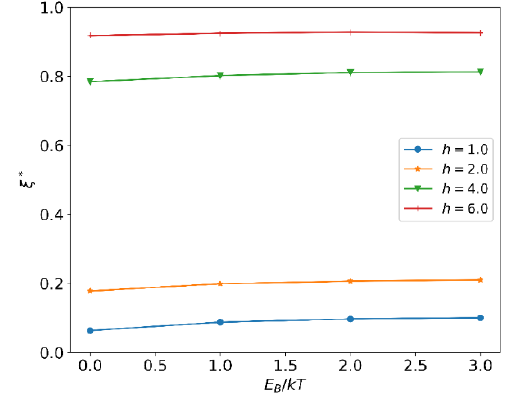
Figure 3. The normalized extent of reaction 𝜉 ∗ at different 𝐸 𝐵 .